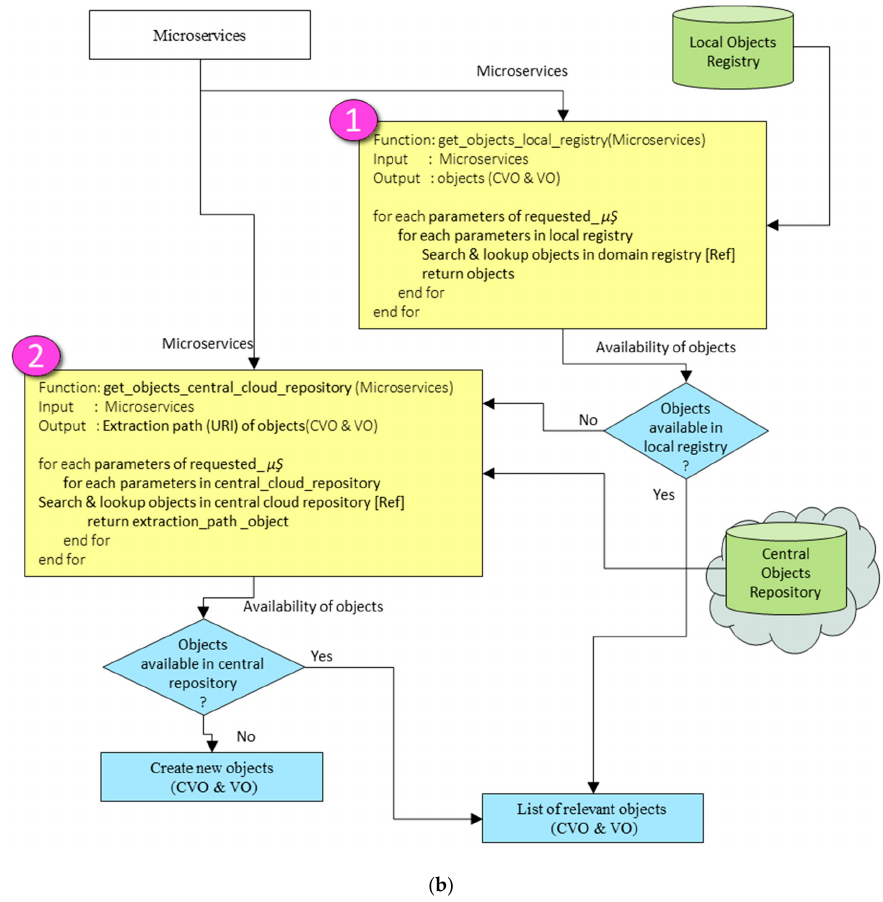
Figure 3. ( a ) Microservices discovery and lookup algorithm; and ( b ) microservices relevant objects discovery and lookup algorithm.